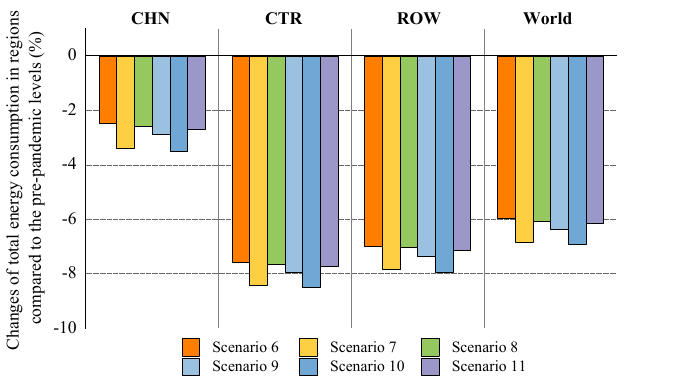
Figure 8. The impact of global pandemic spread on total energy consumption in trade regions in the context of trade protectionism.